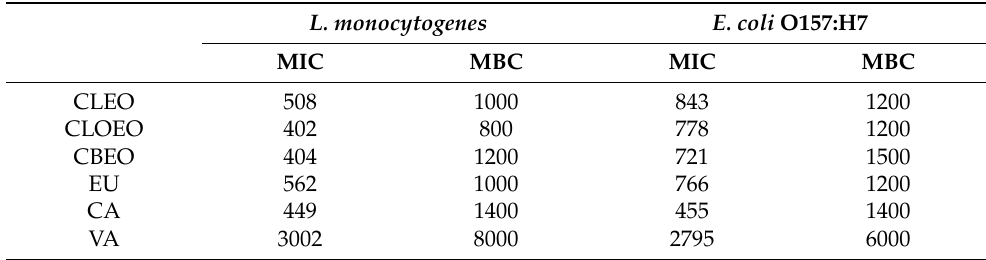
Table 1. Antimicrobial activity of the tested antimicrobials against L. monocytogenes and E. coli O157:H7. MIC and MBC values are expressed in